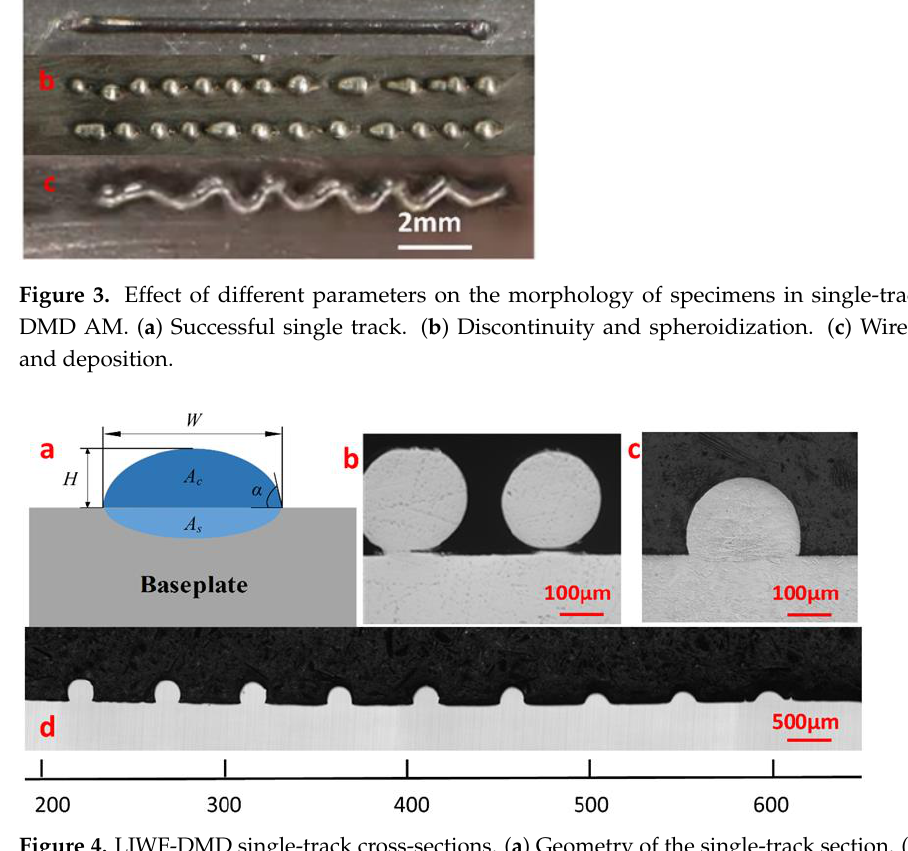
Figure 3. Effect of different parameters on the morphology of specimens in single-track LJWF-DMD AM. ( a ) Successful single track. ( b ) Discontinuity and spheroidization. ( c ) Wire bending and depo- sition.